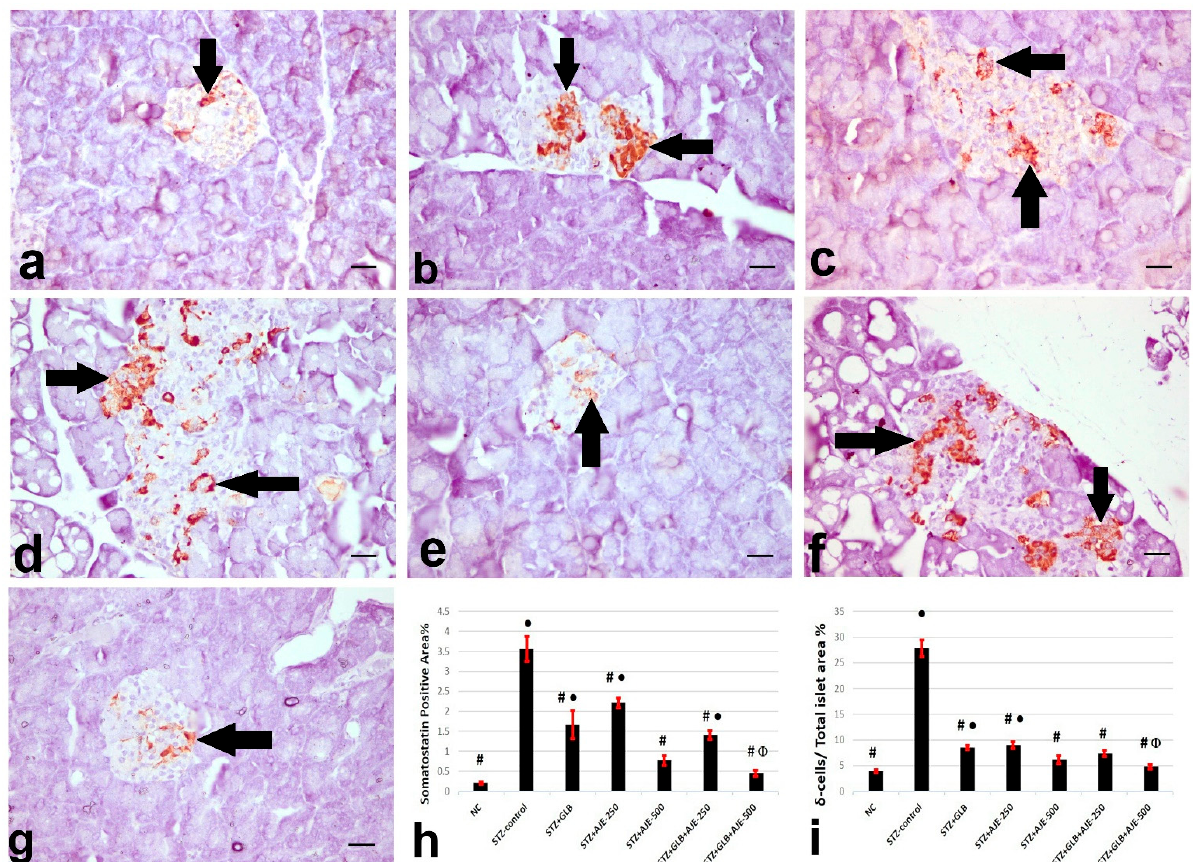
Figure 4. Represented somatostatin immunohistochemistry in the δ -cells (arrows) of the pancreatic islets of the different experimental groups. ( a ) NC group, ( b ) STZ-control group, ( c ) STZ + GLB-treated group, ( d ) STZ + AJE-250, ( e ) STZ + AJE-500 group, ( f ) STZ + GLB + AJE-250, and ( g ) STZ + GLB + AJE-500 group; scale bar, 25 µm. ( h ) Bar chart represents the glucagon content of δ -cells %. ( i ) δ -cell/total islet area %. Data are presented as the mean ± SEM ( n = 7). ● Statistically significant difference from the NC group at p ≤ 0.05. # Statistically significant difference from the STZ-control group at p ≤ 0.05. Φ Statistically significant difference from the GLB group at p ≤ 0.05.